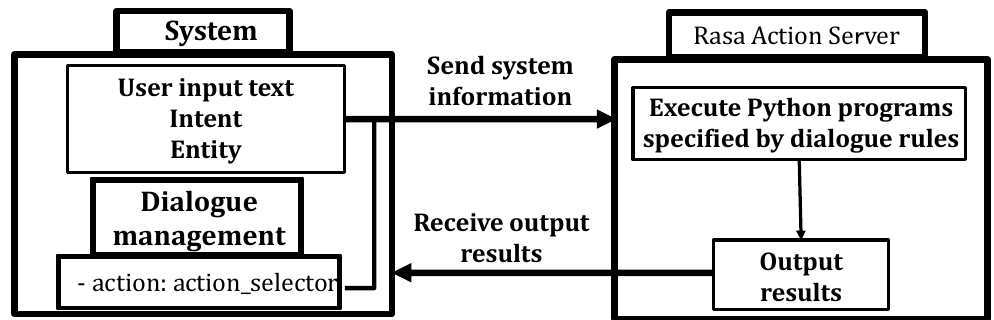
Figure 5. Details of Rasa Action Server.